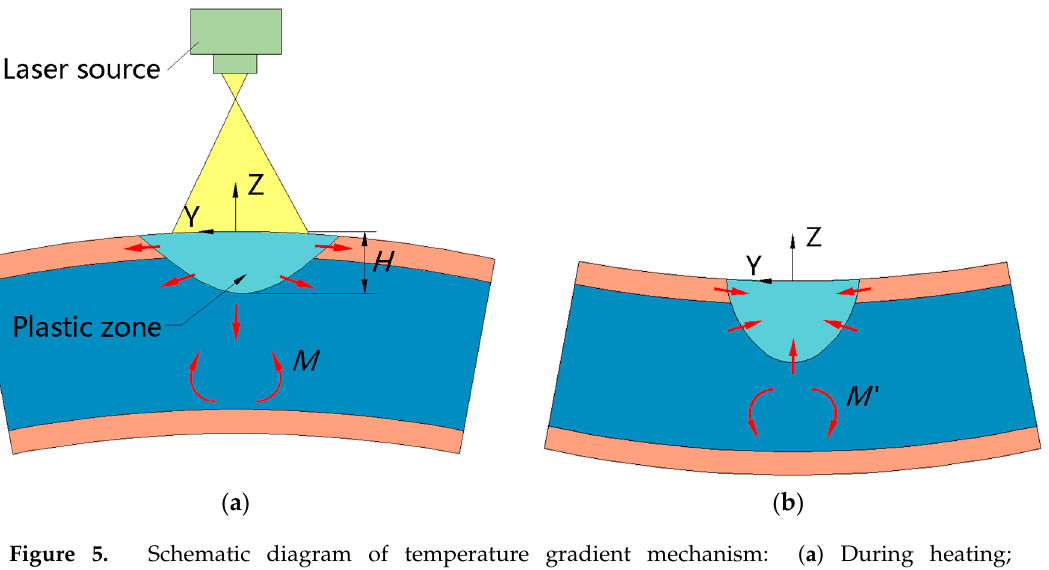
Figure 5. Schematic diagram of temperature gradient mechanism: ( a ) During heating; ( b ) during cooling.